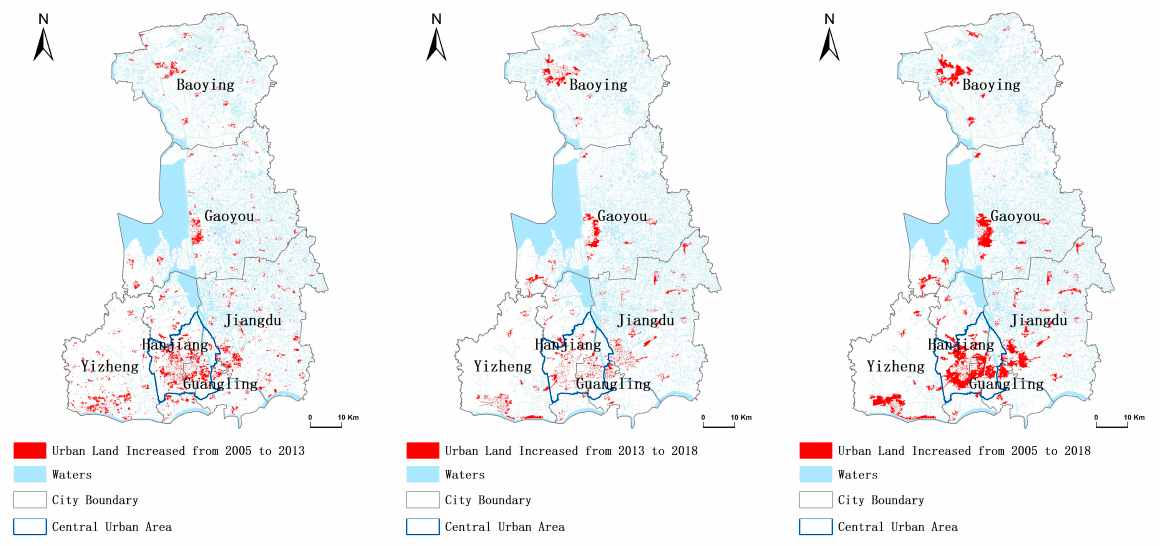
Figure 3. Patch distribution of urban land expansion in Yangzhou. Table 2. Source analysis of urban land expansion in Yangzhou (unit: hm 2